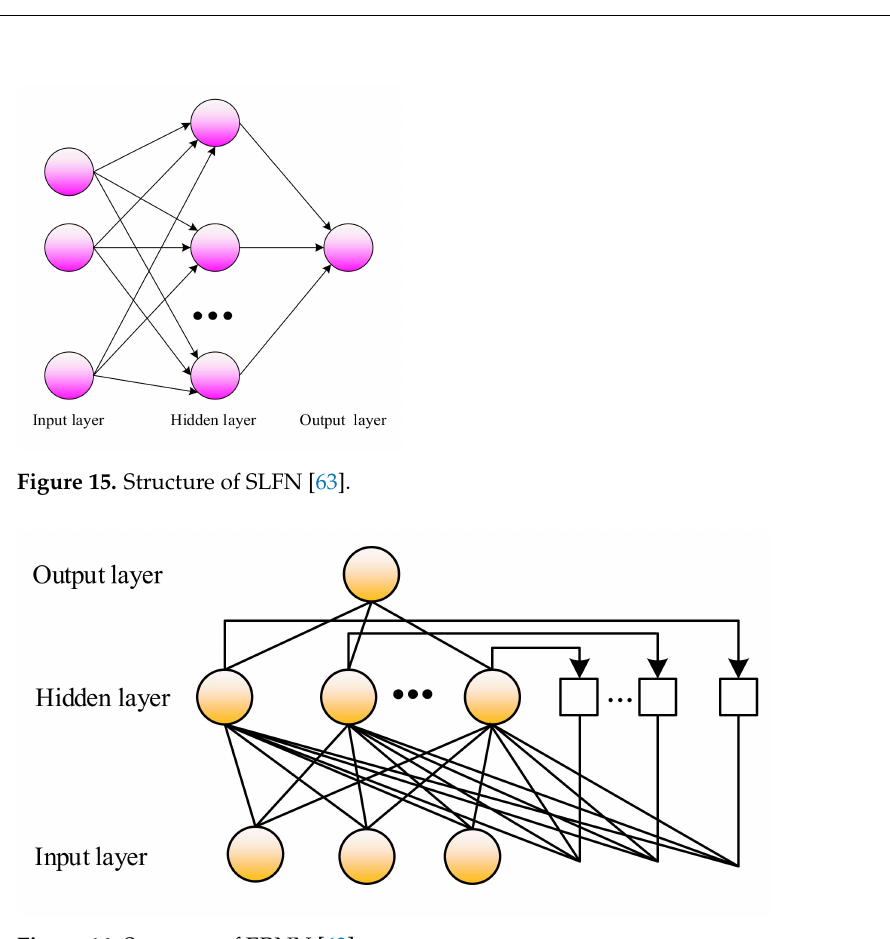
Figure 16. Structure of ERNN [63]. Table 7. Fault detection accuracy comparison with other